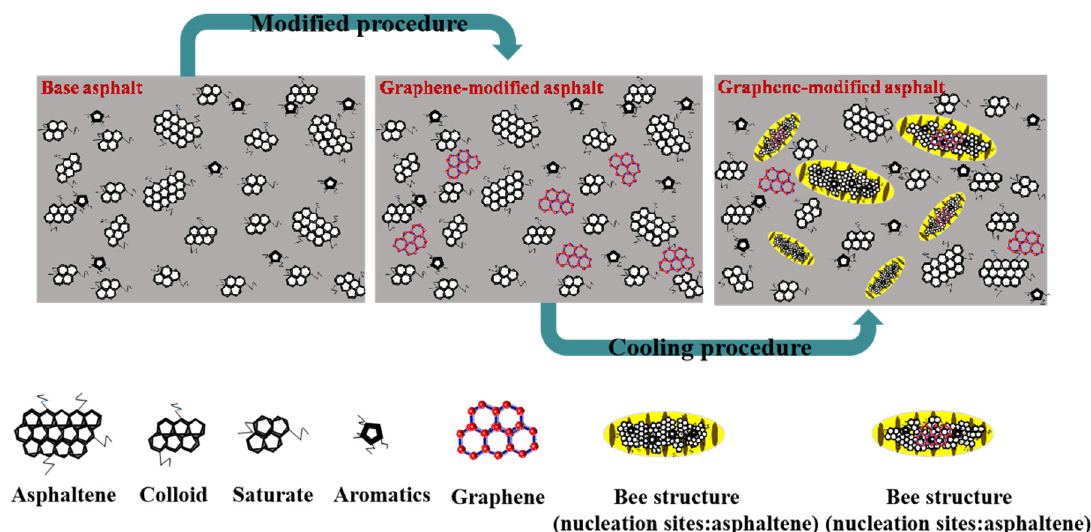
Figure 7. Schematic diagram of precipitation process of “bee structures”.